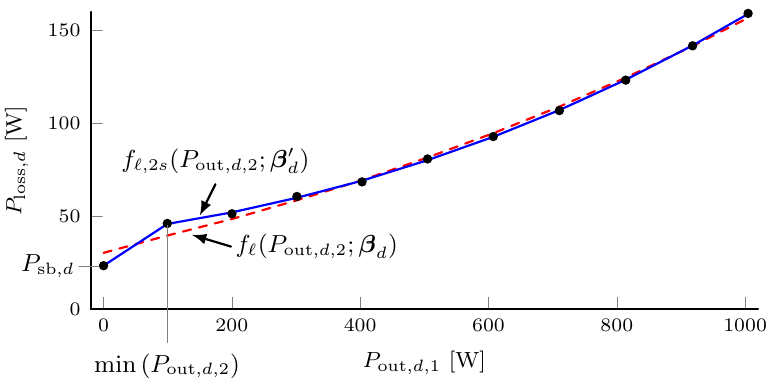
Figure 11. Comparison of two-state loss model (blue, solid) to an uncorrected loss model (dashed, red); power loss measurements are shown as black